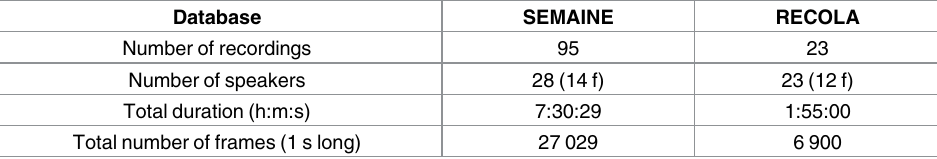
Table 2. Overview of the speech databases used in this paper (f: